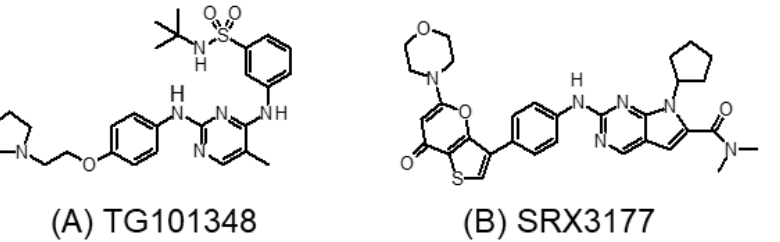
Figure 7. Chemical structures of the tyrosine kinases and BET dual inhibitors discussed: ( A ) TG101348, and ( B ) SRX3177.